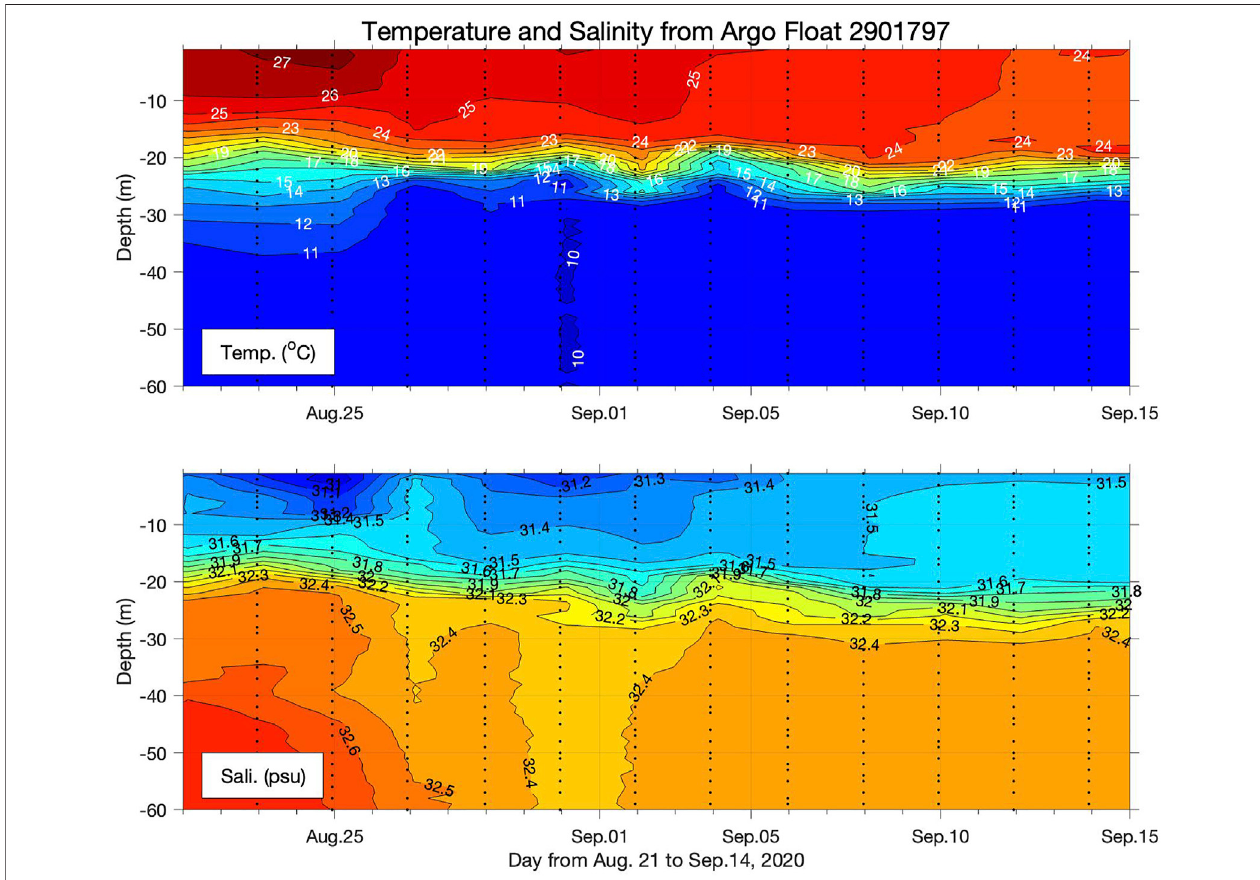
FIGURE 5 | Vertical distribution of water temperature and salinity in the Yellow Sea obtained by Argo fl oat 2901797 from August 21 to September 14, 2020. The black dots indicate the observation depths.